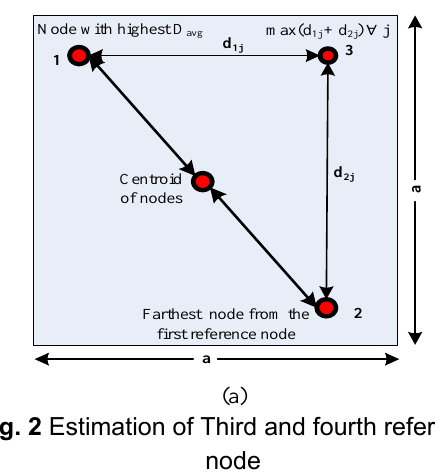
Fig. 2 Estimation of Third and fourth reference